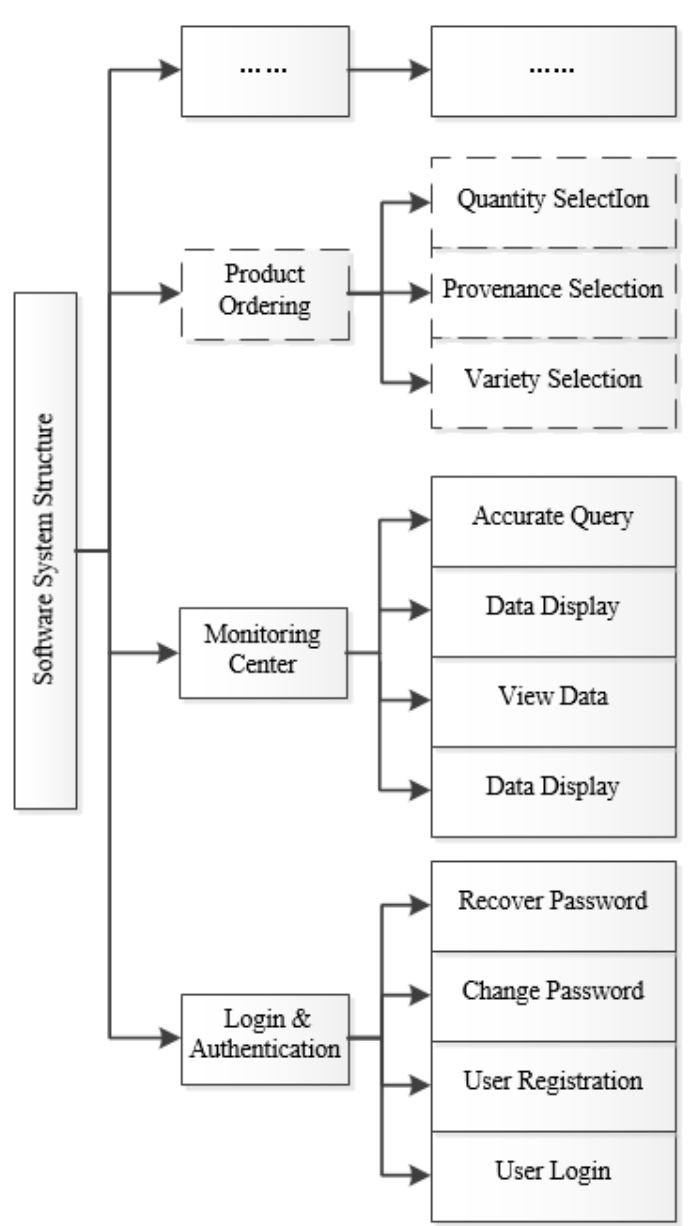
Figure 8. Functional design of software for consumers.